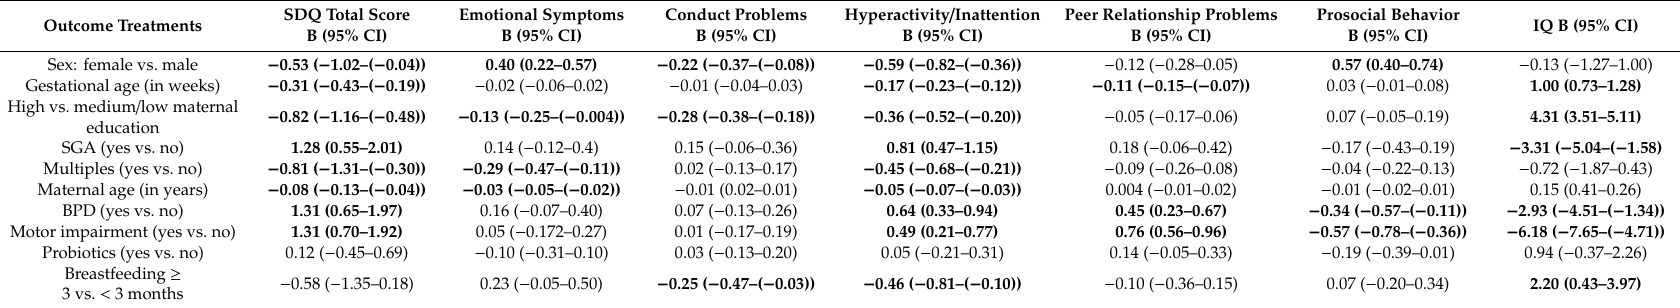
Table 2. Multivariable linear regression analysis for outcomes of the strength and di ffi culties questionnaire (SDQ), total and subscores (higher values indicating worse outcomes) and intelligence quotient (IQ; higher values indicating more